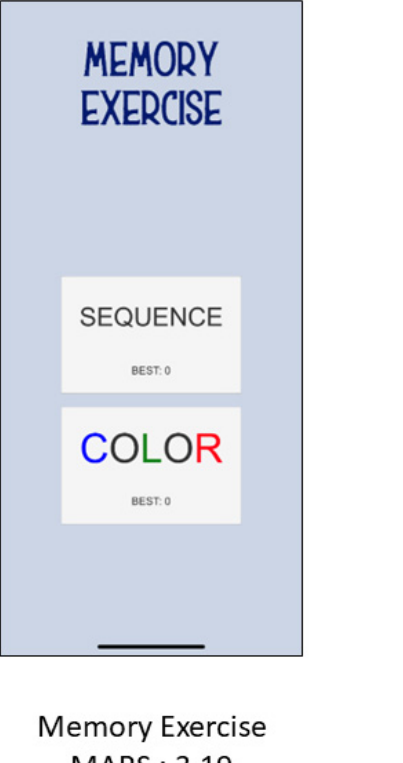
Figure 2. Two application interfaces with MARS scores.